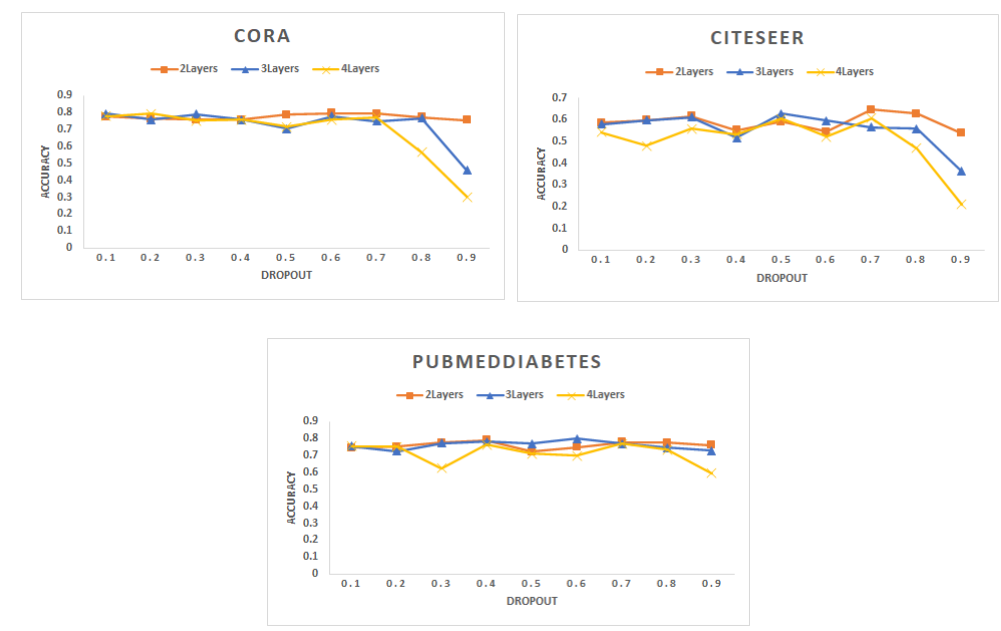
Figure 3. Accuracy for different networks varying the dropout hyperparameter with a different number of